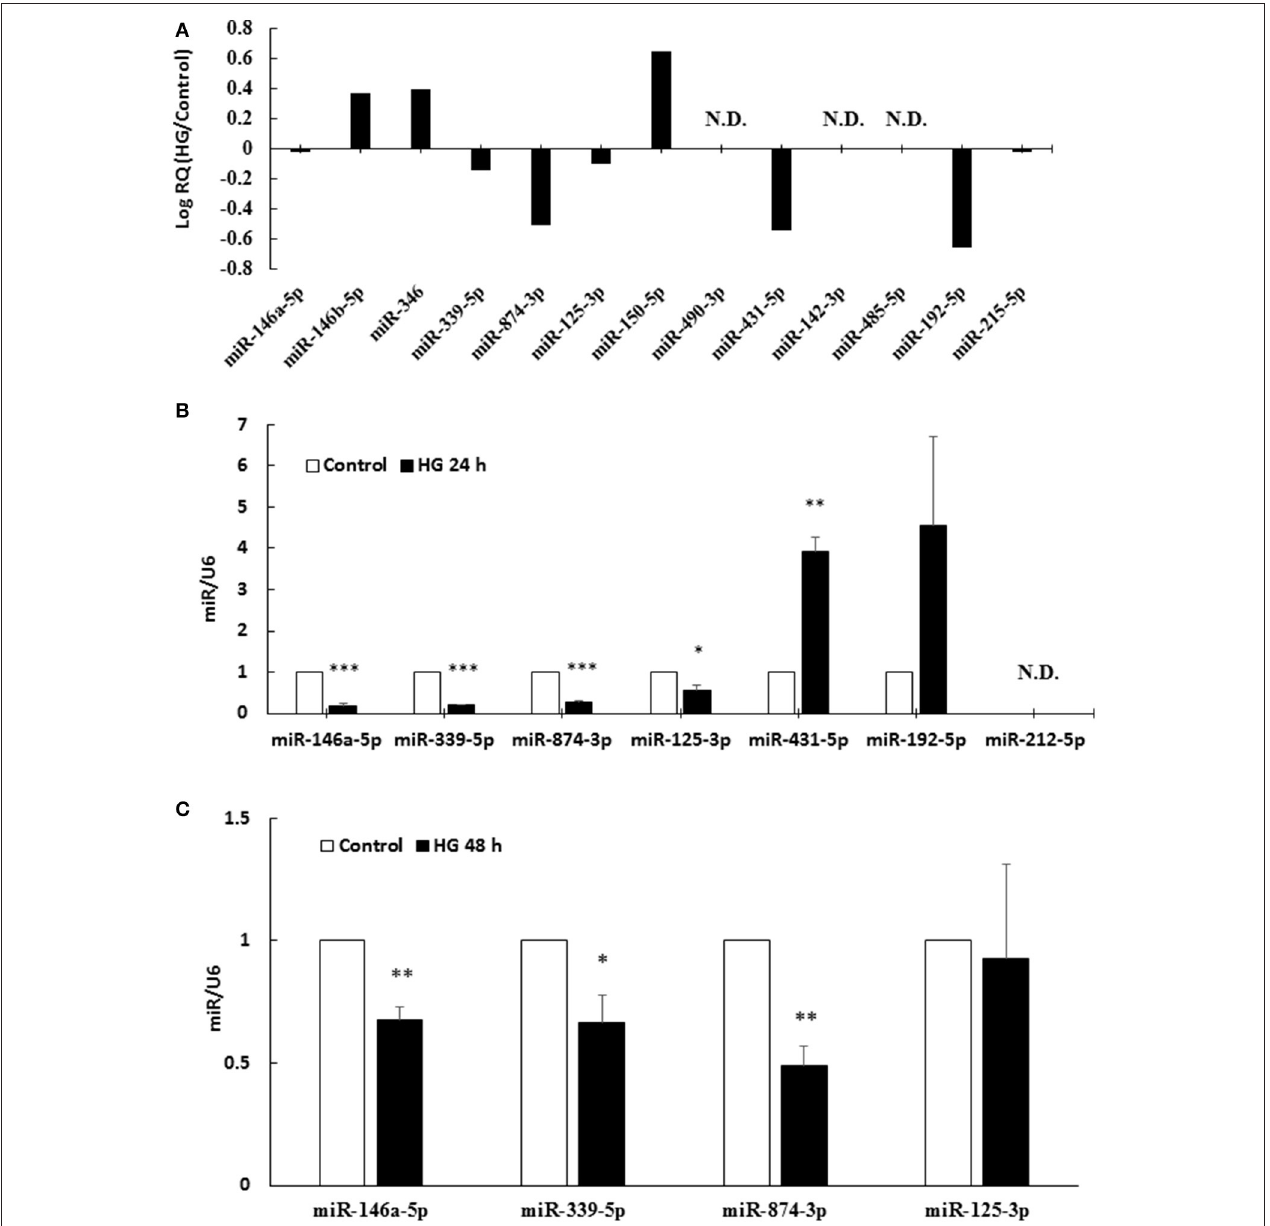
FIGURE 2 | (A–C) MiR-146a-5p, miR-339-5p, and miR-874-3p were downregulated in 24 and 48 h HG-treated HAECs. (A) The TaqMan ® Array Human MicroRNA Card contained all 13 possible miRs targeting IRAK-1. From left to right, the 13 miRs are ordered according to their absolute value of mirSVR score. HG stimulation for 24 h revealed that seven miRs, miR-146a-5p, miR-339-5p, miR-874-3p, miR-125-3p, miR-431-5p, miR-192-5p, and miR-215-5p, were downregulated by HG, as compared with unstimulated control. The 13 miR expression levels are expressed as log Relative Quantity (HG/control). N.D., not detected. (B) Seven downregulated miRs found via TaqMan ® Array were confirmed by real-time PCR. HG stimulation for 24 h decreased miR-146a-5p, miR-339-5p, miR-874-3p, and miR-125-3p expression levels to 18, 20, 28, and 54% of the control level, respectively. n = 3. * p < 0.05, ** p < 0.01, and *** p < 0.001, compared with the control ( t -test). The levels of the miRs are expressed as the ratios of U6 levels. (C) Four downregulated miRs, as shown by 24 h real-time PCR, were further examined in the 48 h experiment. HG stimulation for 48 h decreased miR-146a-5p, miR-339-5p, and miR-874-3p to 68, 60, and 49% of the control level, respectively. n = 3. * p < 0.05 and ** p < 0.01, compared with the control ( t -test). The levels of the miRs are expressed as the ratios of U6 levels.